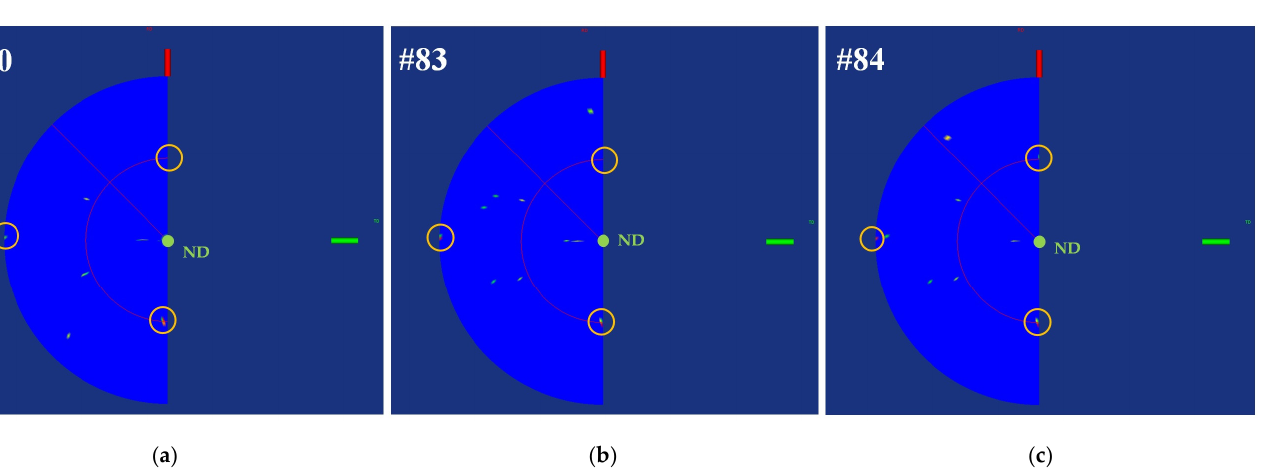
( c ) Figure 9. The experimental RSMs for the samples #80 ( a ), #83 ( b ), #84 ( c ) near the (220) reciprocal lattice point. The arrow marks the crystallographic direction [1(cid:3364)10] (according to the direction of the base cut, which was indicated by the arrow on the samples). The intensity is normalized to the peak intensity for each of the RSMs. The RSM of the studied samples #80, #83, #84 differ significantly. The major differ- ence appears in the form and intensity of diffuse scattering, which occurs due to scattering at the crystal structure defects. Diffuse scattering in sample #80 is very small, which means